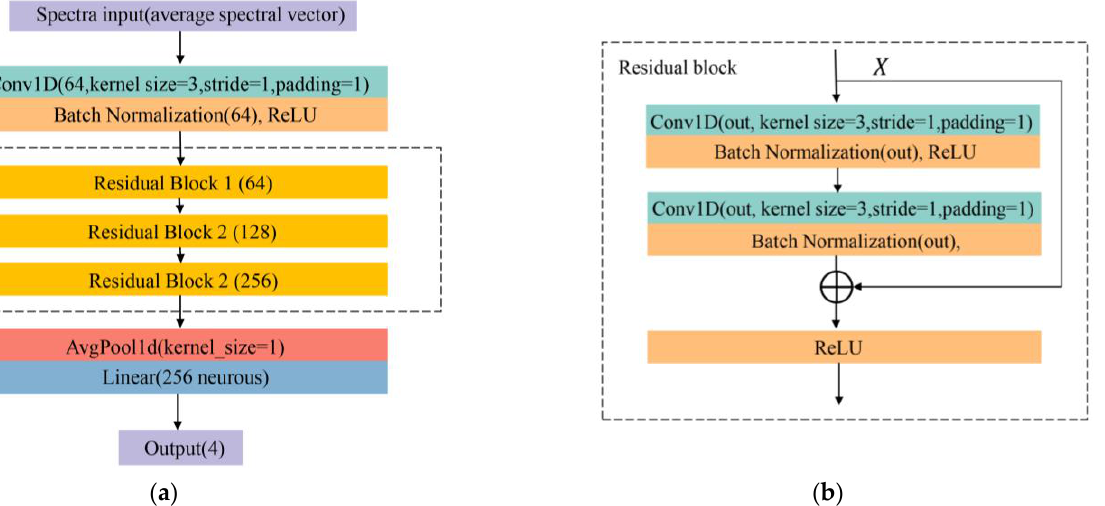
Figure 4. The proposed residual neural network (ResNet) ( a ) and residual block ( b ) structures for the identification of pesticide residues in grapes.